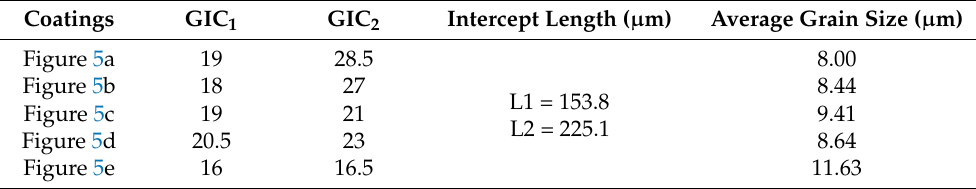
Figure 5. SEM morphology of the coating cross-sections before and after annealing treatment: ( a ) before annealing; ( b ) 450 °C for 2 h; ( c ) 650 °C for 2 h; ( d ) 850 °C for 0.5 h; ( e ) 850 °C for 2 h; ( f ) average grain size of the above coatings. Table 4. Measuring results of average grain size with linear intercept